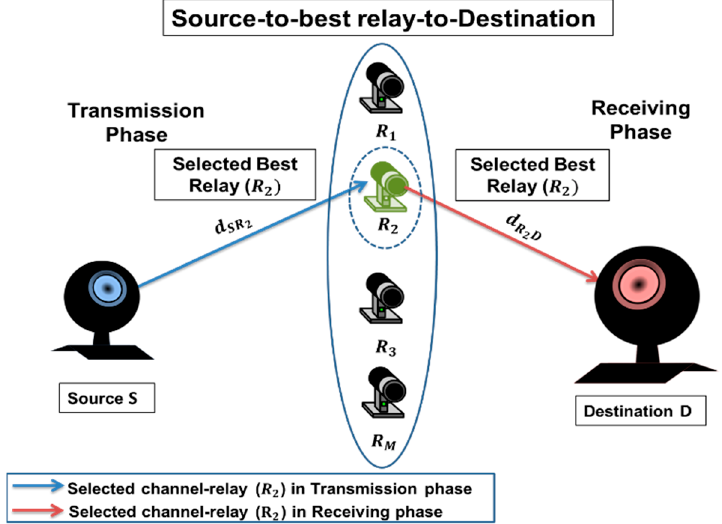
Figure. 1 Source ‐ relay ‐ destination scheme.